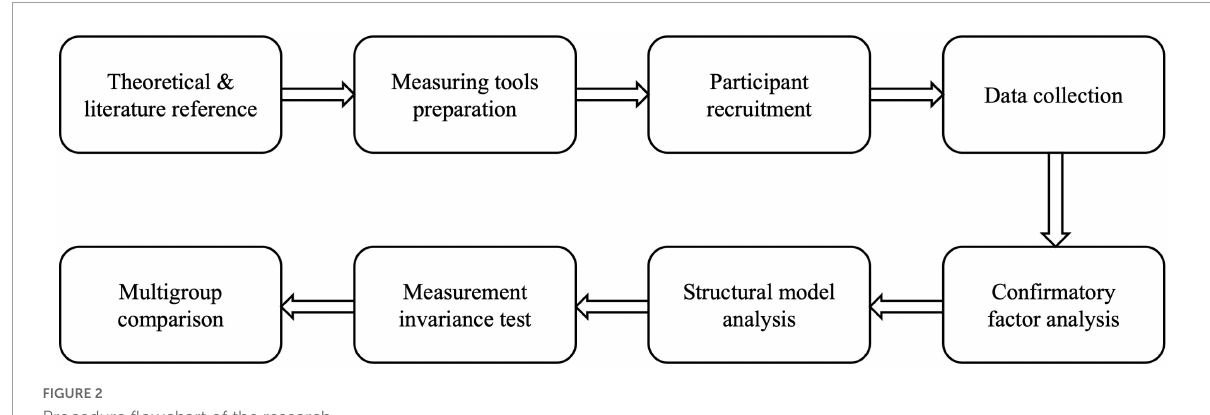
FIGURE2 Procedure flowchart of the